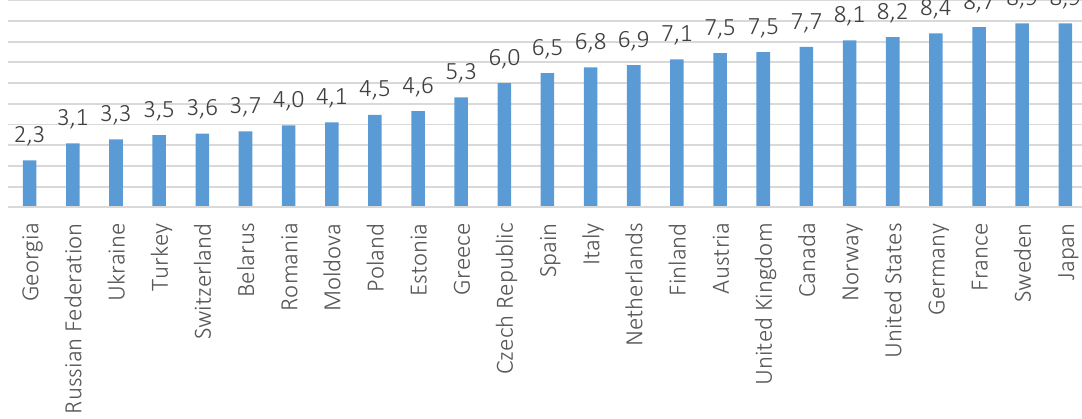
Figure 6. Average domestic general government health expenditure (2010–2017), % of GDP